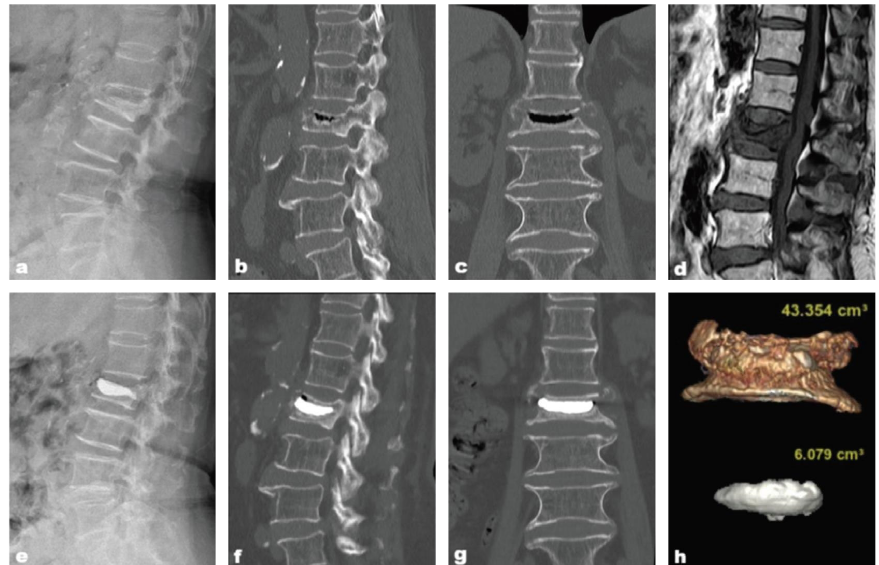
Figure 1: An 80-year-old female patient is diagnosed with an L2 osteoporotic vertebral compression fracture (OVCF). (a) Preoperative lateral X-ray. (b) Preoperative sagittal CT. (c) Preoperative coronal CT. (d) Preoperative MRI. (e) Postoperative lateral X-ray. (f) Postoperative sagittal CT. (g) Postoperative coronal CT. (h) 3D image of the vertebral body and bone cement.